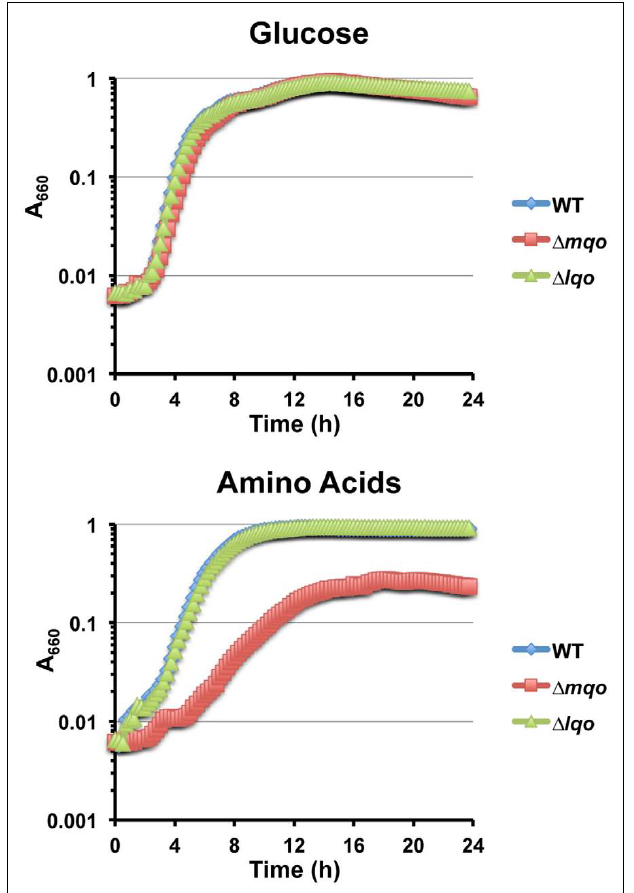
FIGUREA2 | Lqo and Mqo are differentially required for utilization of various carbon sources. TOP: Neither Mqo nor Lqo are essential for growth in chemically defined media using glucose (0.5%) as a primary carbon source. BOTTOM:While Mqo is dispensable for growth on L-lactate (Figure 2) it is essential for maximal growth in chemically defined media using amino acids (0.5% Cas Amino Acids) as a primary carbon source.